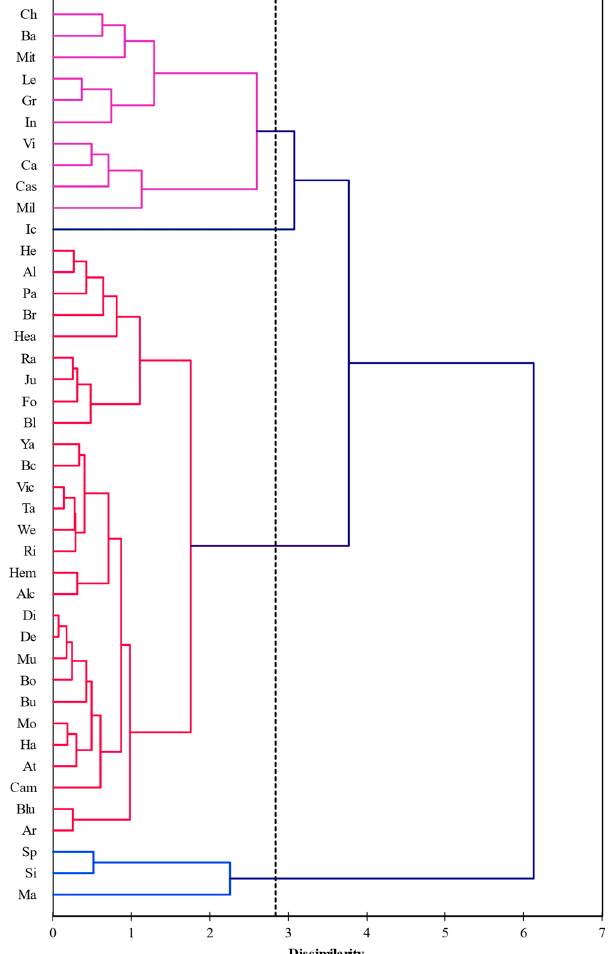
Figure 2. Dendrogram generated by the cluster analysis on three PLS components ( t 1, t 2, and t 3) shows the relationships among the studied bulls. Different colored lines show four main groups of bulls.